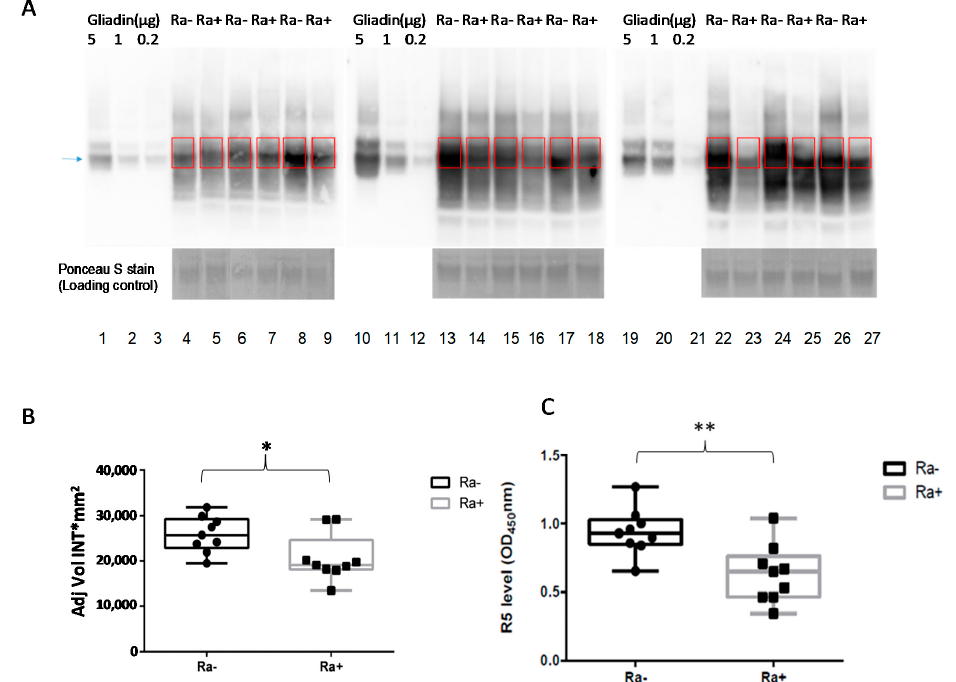
Figure 2. Gliadin degradation in vivo by Rothia bacteria. ( A ) Two groups of mice (M) were fed chow without R. aeria and chow with R. aeria . Aliquots (160 µg protein) of the gastric samples with (Ra+) and without (Ra − ) bacteria (n = 9/group) were subjected to immunoblotting with an anti-gliadin antibody. Lane 1, 2, 3; 10, 11, 12; 19, 20, 21: Gliadin control (5, 1 and 0.2 µg), respectively; Lanes 4, 6, 8, 13, 15, 17, 22, 24, 26: the nine mice fed chow without R. aeria bacteria Ra ( − ); Lanes 5, 7, 9, 14, 16, 18, 23, 25, 27: the nine mice fed chow with R. aeria bacteria Ra (+). The blue (arrow) pointed to the gliadin bands at 37 kDa. ( B ) Densitometric analysis of the major gliadin protein bands (shown in A ); data points represent the average of the remaining gliadin amount (AU). The data represent three independent experiments and the error bars ± SEM. * p < 0.05. C, R5 epitope levels, expressed in OD450nm, in stomach samples from mice fed chow supplemented with R. aeria (Ra+) and without R. aeria (Ra − ). The data are representative of three independent experiments and the error bars represent the average ± SEM. ** p < 0.01.